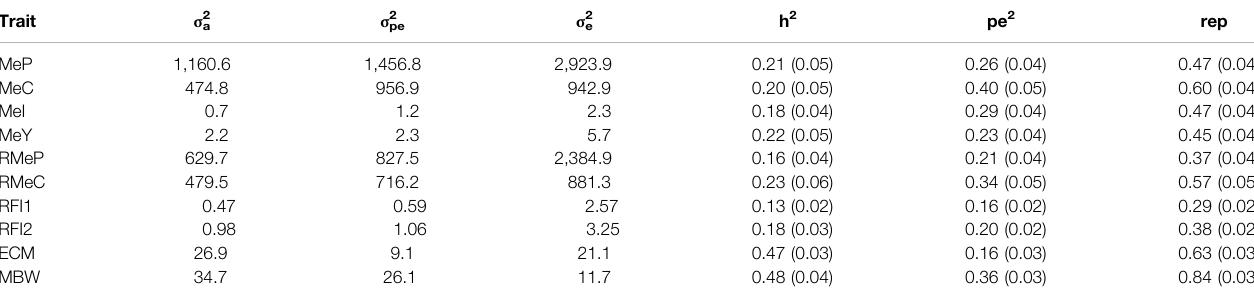
TABLE 2| Estimated genetic ( σ 2 a ),permanentenvironmental ( σ 2 pe ),residual ( σ 2 e ) variances, heritabilities (h 2 ),permanentenvironmental ratios (pe 2 )and repeatabilities (rep) with (SE) for methane, production, maintenance, and ef fi ciency traits. Trait